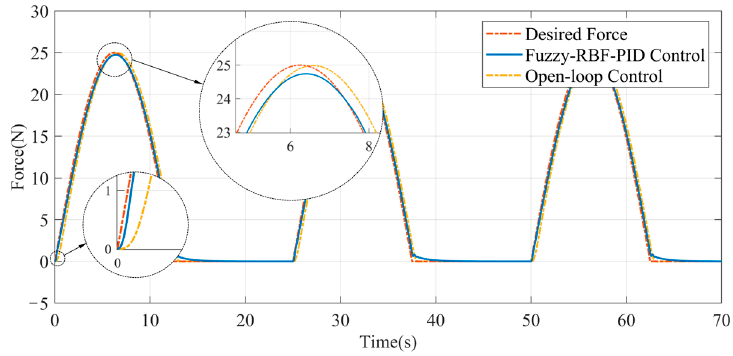
Figure 7. Forward sinusoidal response curve of Fuzzy-RBF-PID control.